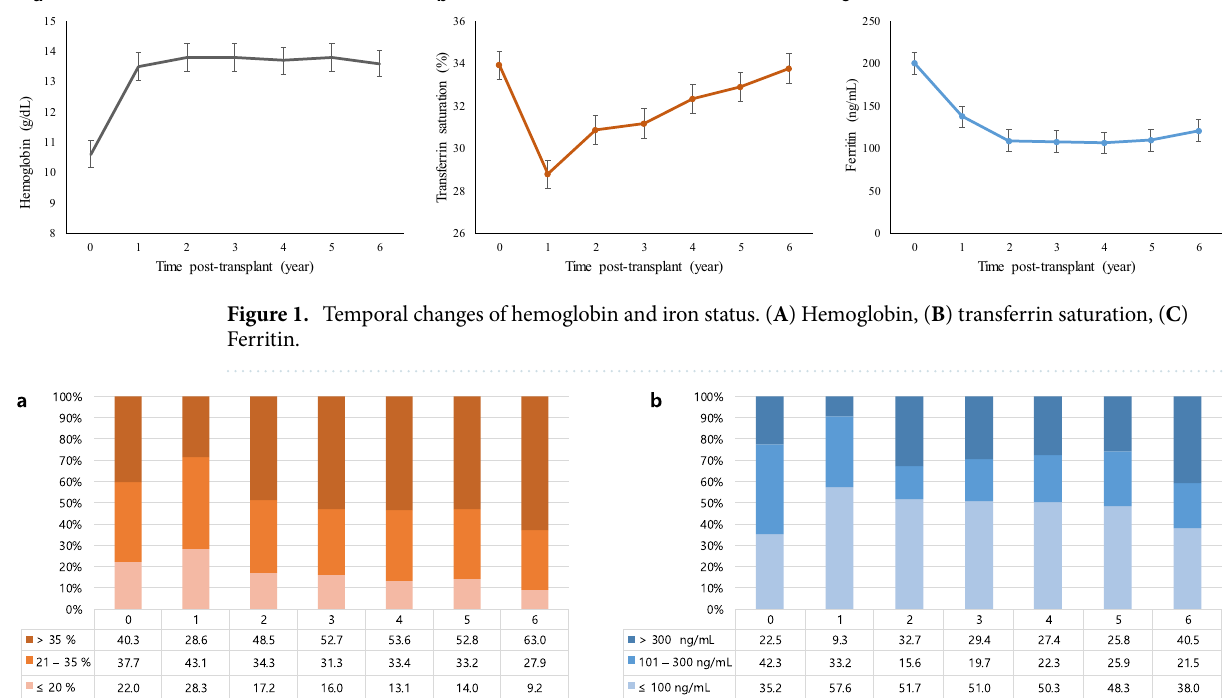
Figure 2. Temporal changes of iron groups according to transferrin saturation levels ( A ) and ferritin levels ( B ). Number of person-years Number of events (%) Incidence rate a Table 2. Outcome event rates with respect to the TSAT, ferritin, and iron status classification. a Per 1000 person-years. The primary outcome was composite of all-cause mortality, graft failure, and eGFR ≥ 50%. Graft failure is defined as the development of kidney failure requiring dialysis or KT, or death with a functional graft. TSAT transferrin saturation, eGFR estimated glomerular filtration rate, KT kidney transplantation.